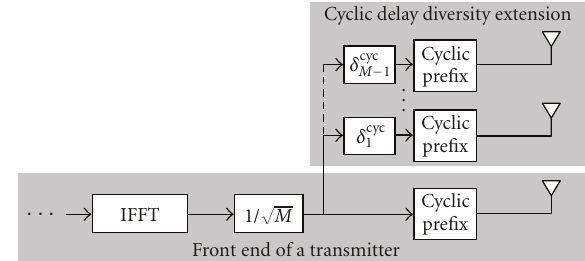
Figure 4: Principle of cyclic delay